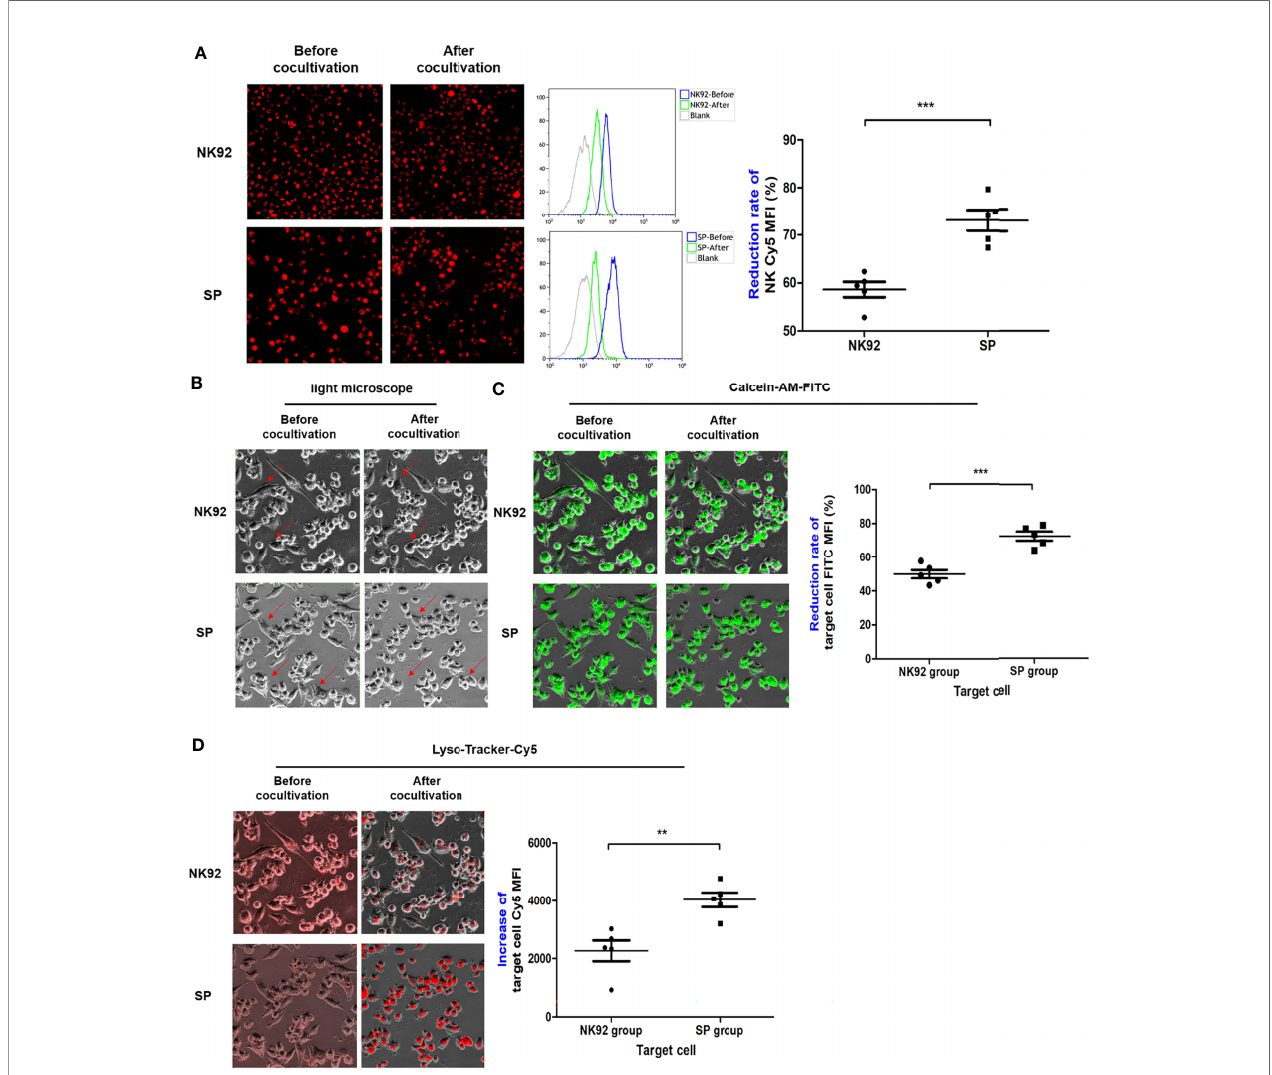
FIGURE 7 | The degranulation of SP and the targeted delivery of cytotoxic granule content were more ef fi cient and lethal. (A) After co-culture, effector cells were collected and the changes in red fl uorescence were detected by FCM, indicating the lysosome exocytosis. Morphological changes in target cells before and after co- culture were observed in bright fi eld (B) , while FITC channel for (C) quantitative assessment of lysosomes entering target cells as indicated by increased red fl uorescence mean fl uorescence intensity (MFI) (Cy5 channel). (D) Target cells death as indicated by green fl uorescence (MFI FITC decrease). All summary data showed mean ± SEM, n = 5 different fi elds. **P < 0.01, ***P <